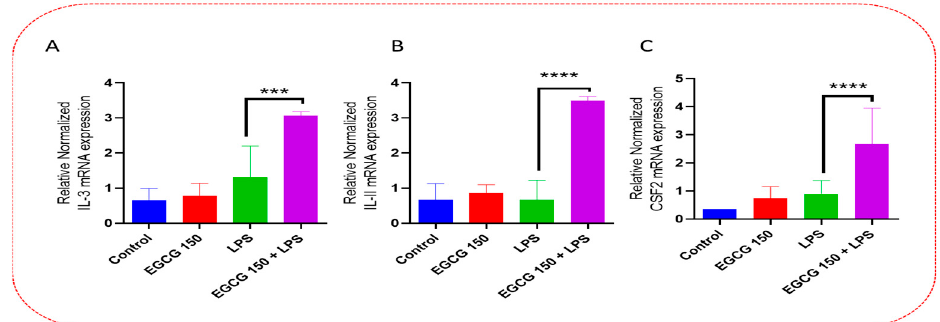
Figure 5. EGCG upregulates IL-3, IL-11, and CSF2. PCR array analysis of BV-2 cells shows that EGCG 150 µ M + LPS (1 µ g/mL) significantly increased mRNA expression of IL-3 ( A ), IL-11 ( B ), and CSF2 ( C ) compared to LPS (1 µ g/mL). LPS (1 µ g/mL) showed a non-significant increase when compared to EGCG 150 µ M with LPS (1 µ g/mL). The controls (untreated cells and EGCG 150 µ M alone) displayed reduced mRNA expression when compared to LPS and EGCG 150 µ M with LPS (1 µ g/mL). Values represent the mean ± SD, *** p ≤ 0.001, and **** p ≤ 0.0001 vs. LPS.